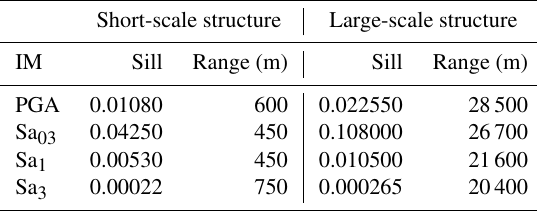
Table A1. Sill and range values of the nested exponential model for all the predicted IM